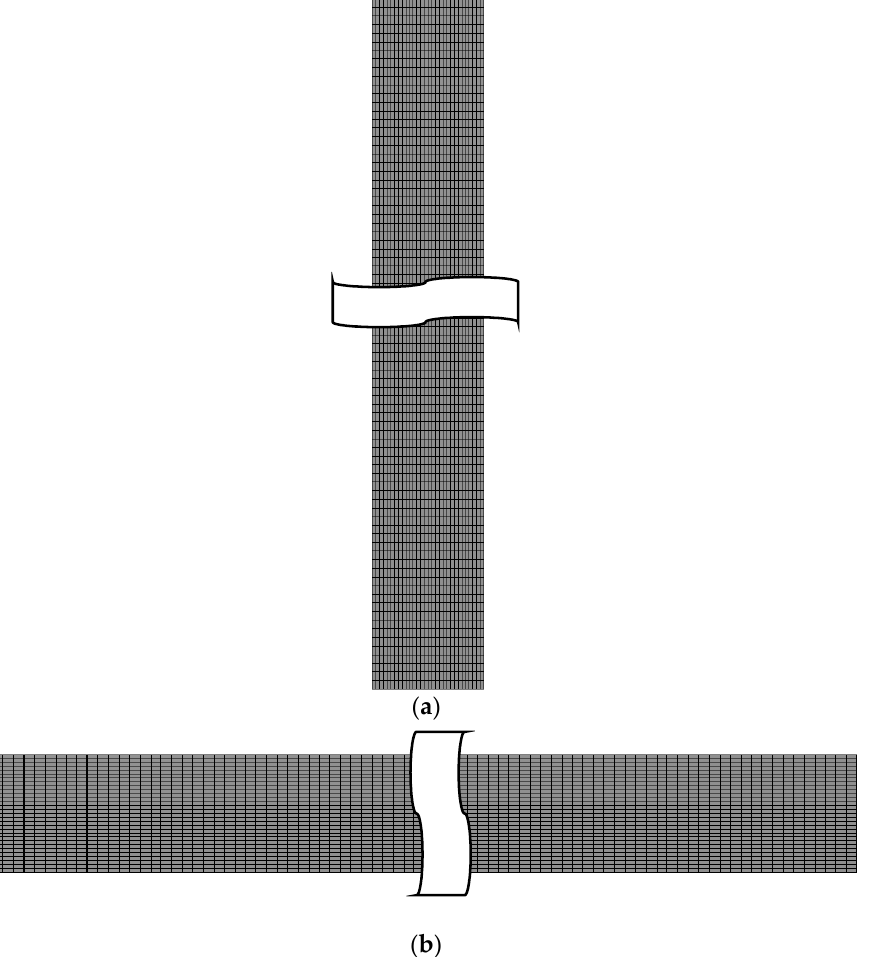
Figure 3. Computational grid systems: ( a ) A vertical electrolysis cell; ( b ) A horizontal/vertical electrolysis cell.